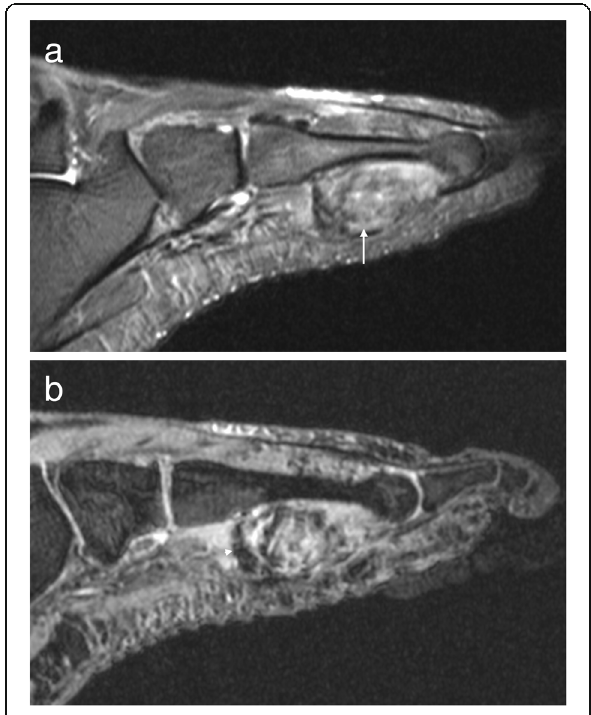
Fig. 8 Giant cell tumour of the tendon sheath. a Sagittal T2FS image shows a heterogeneously hyperintense lesion underlying the metatarsal, related to the flexor tendon. b Gradient echo imaging shows foci of blooming